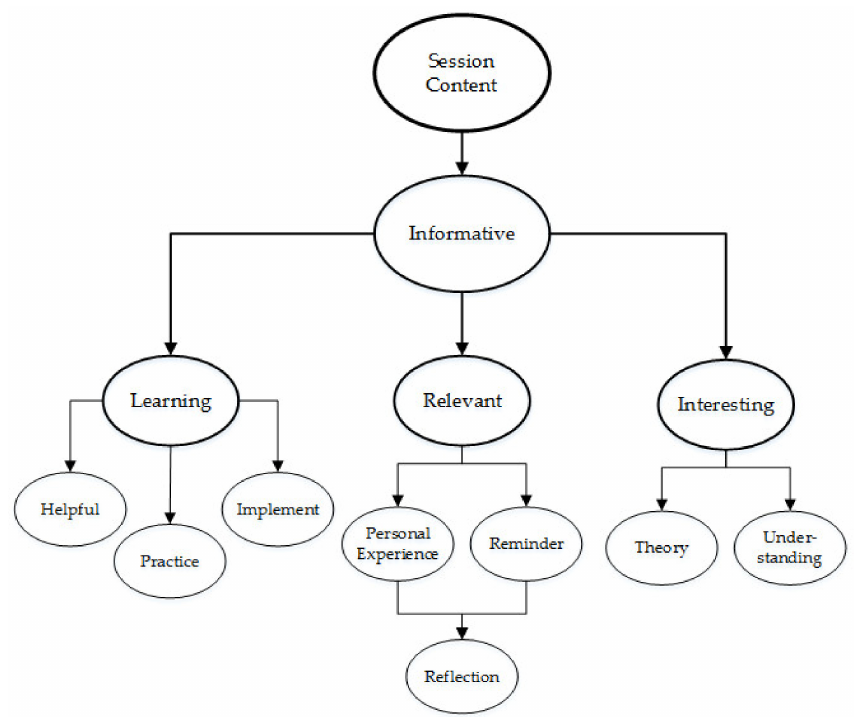
Figure 4. Graphic summary of the themes and sub-themes from the participant post-session feedback (session